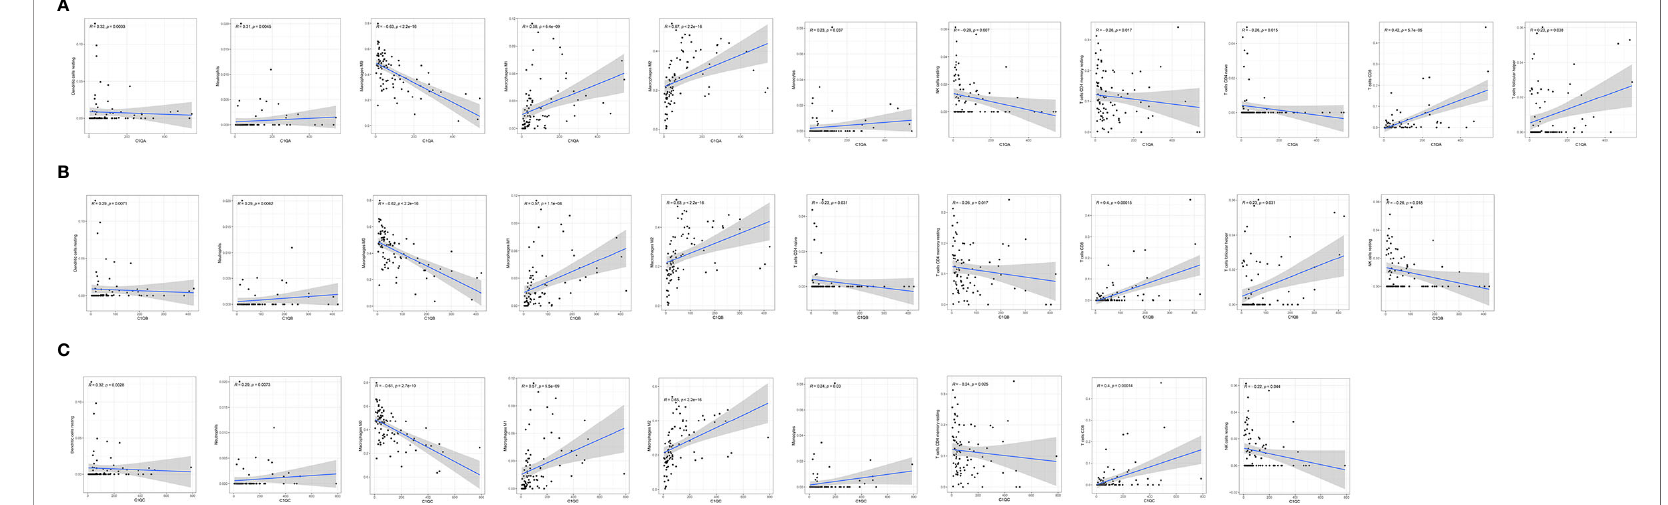
FIGURE 8 | Correlations between C1qA, C1qB, or C1qC expression levels and TIC proportions. (A – C) The scatter plots show the correlations between C1qA, C1qB or C1qC expression levels and TIC proportions ( p < 0.05). The proportion tropism of the immune cells and C1qA, C1qB, and C1qC expression levels are indicated by a fi tted linear model in each plot, as shown by the blue line. Signi fi cance was tested using the Pearson correlation coef fi